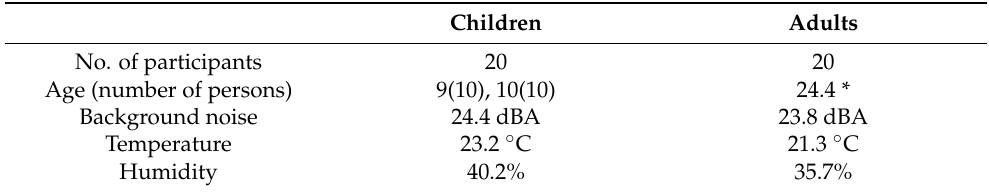
Table 9. General information on speech intelligibility